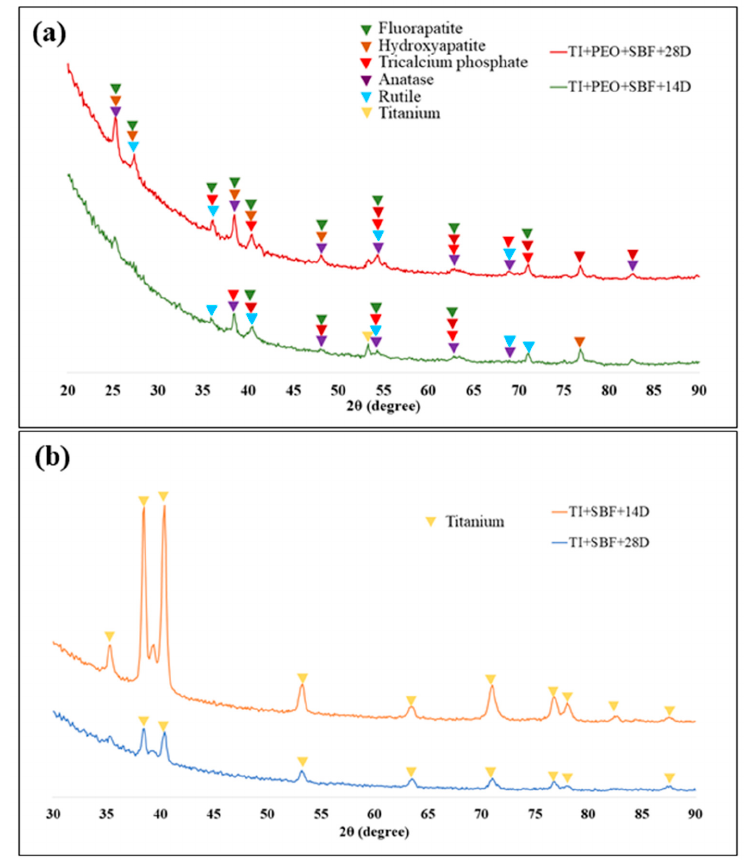
Figure 12. XRD analysis results after the SBF immersion test with two immersion times (14 days and 28 days): ( a ) coated Ti6Al4V substrates; and ( b ) uncoated Ti6Al4V substrates. 28 days): ( a ) coated Ti6Al4V substrates; and ( b ) uncoated Ti6Al4V